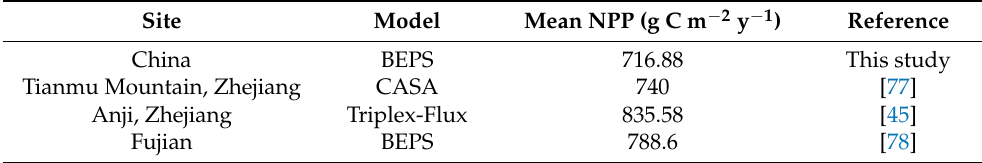
Table 5. Comparison of the simulated NPP results in this study with the simulated results of other